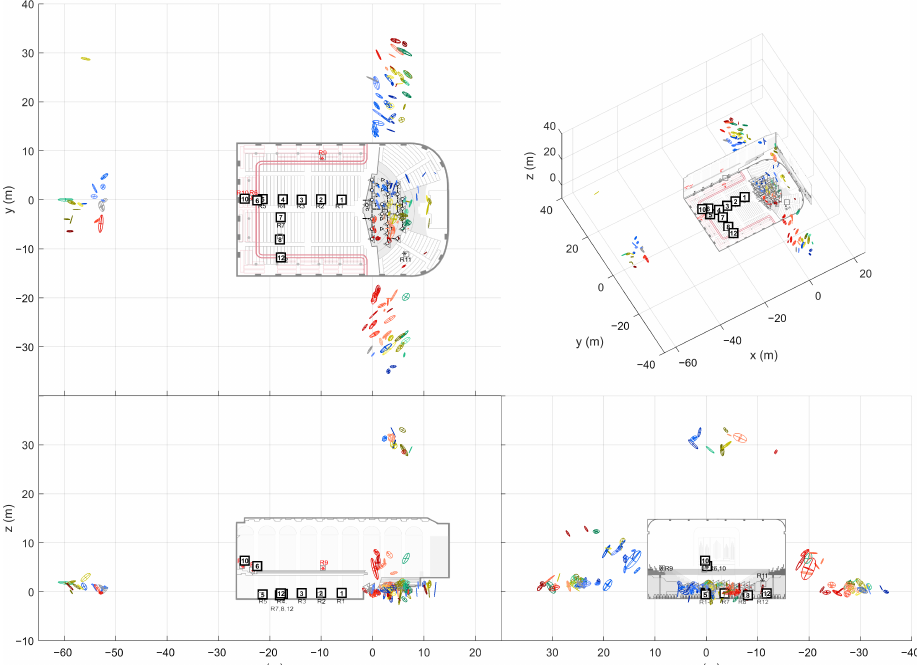
Figure A5. Found image sources for loudspeaker orchestra in Amsterdam Concertgebouw (min. 3 ER objects per image source).